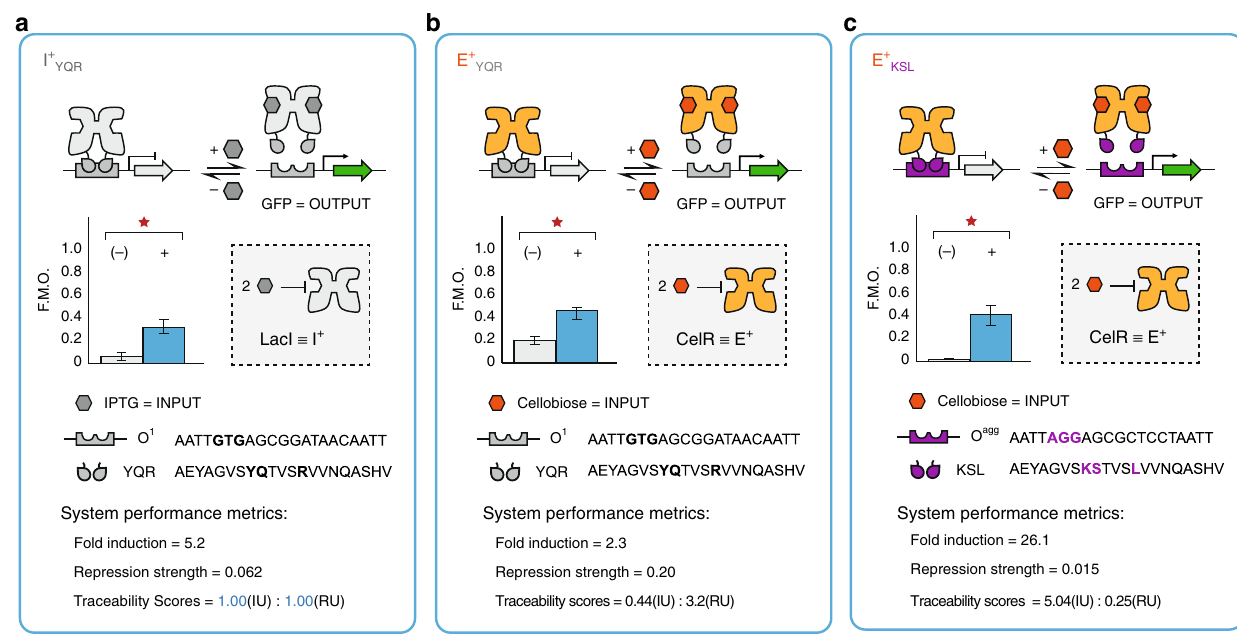
Fig. 3 Performance cards for select repressor-operator combinations. a The I + YQR |O 1 set was designated as the reference system with traceability scores set to 1. b The E + YQR |O 1 and c E + KSL |O agg were selected as relative analog and digital systems, respectively. The context for each performance card displaying the genetic architecture for performance reporting, the properties of the reporter plasmid, the cellular chassis chosen, as well as the details for F.M.O. (Fraction of Maximum Output), IU (Induction Units), RU (Repression Units), and Traceability Scores are given in the supplementary information (Supplementary Fig. 6 and Supplementary Note 2)